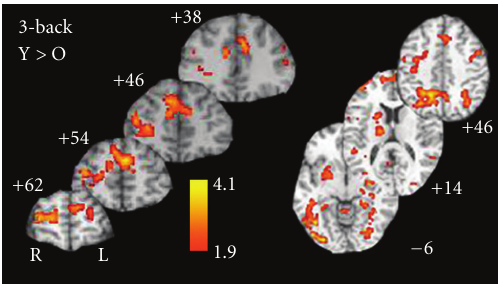
Figure 8: Regions of activation that were di ff erentially greater for younger adults on the 3-back relative to 0-back activation compared to the same contrast in older